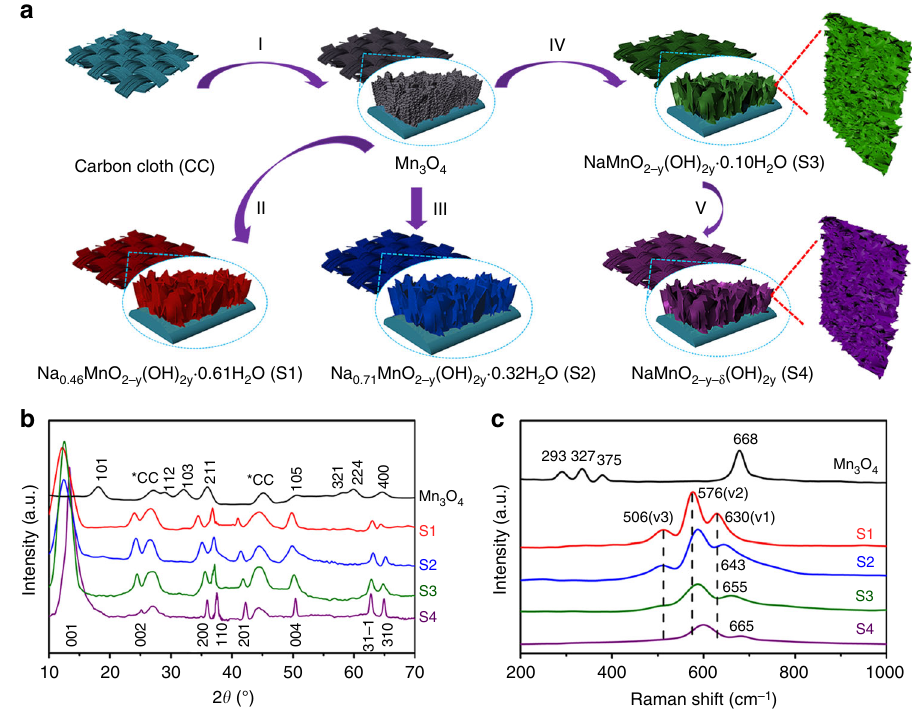
Fig. 1 Synthesis and Structures of Mn 3 O 4 and S1 – S4 samples. a Schematic illustration of fabrication procedure of the porous S1 – S4 nanowall arrays on carbon cloth (I, cathodic deposition of Mn 3 O 4 ; II – IV, hydrothermal treatments at different conditions; V, annealing in Ar atmosphere). b XRD patterns of the Mn 3 O 4 and S1 – S4 samples. c Raman spectra of the Mn 3 O 4 and S1 – S4 samples